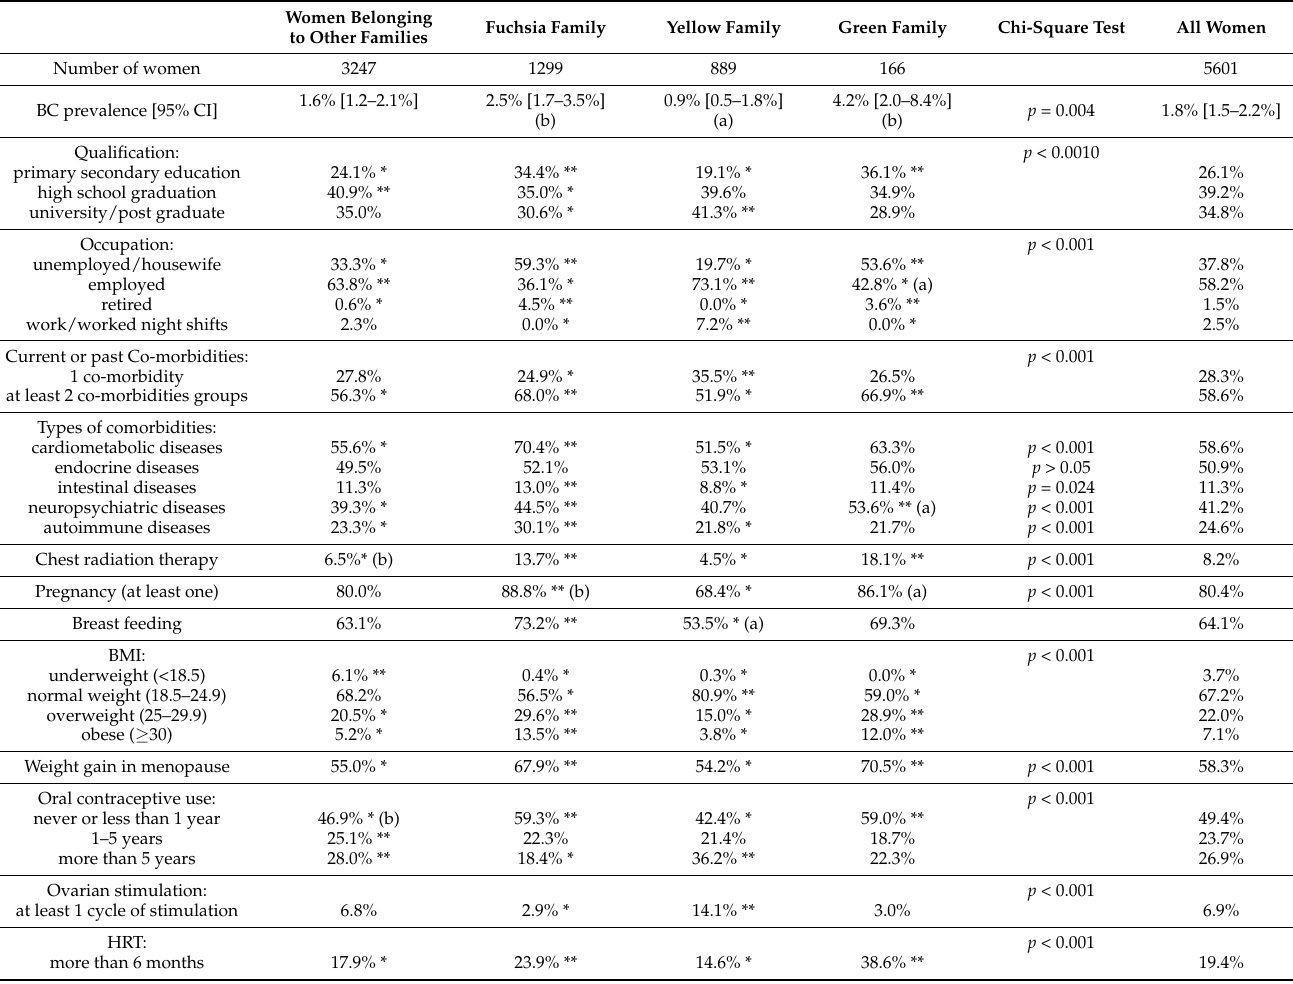
Table 2. Distribution of the characteristics included in the profile 2: overall population of women and focus on the families statistically associated with BC. See Section 3.4 for the description of the communities and the families. Women Belonging to Other Families Fuchsia Family Yellow Family Green Family Chi-Square Test All